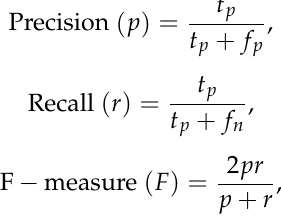
Table 2. Error matrix for the accuracy assessment of cotton boll extraction.